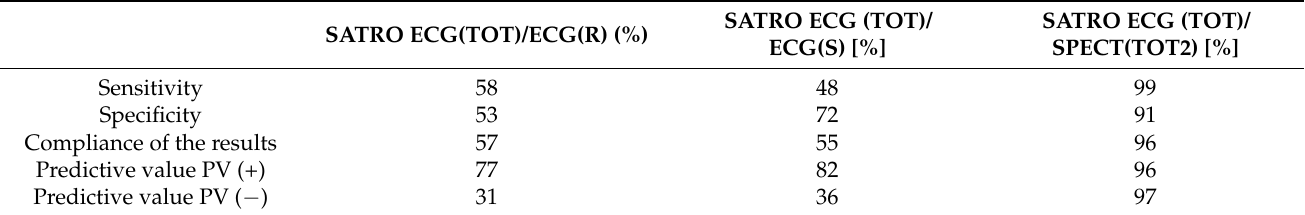
Table 3. Figures describing the diagnostic efficacy of SATRO ECG (TOT) in relation to other